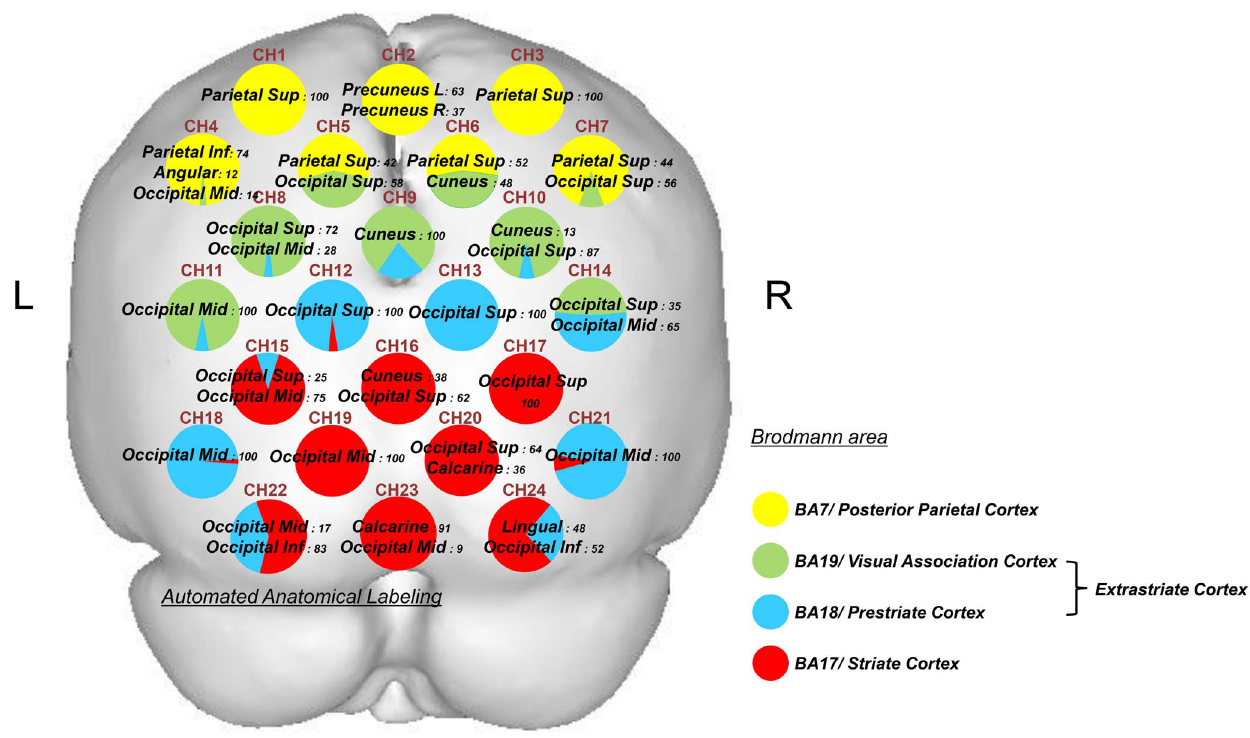
Figure 2. Anatomical identification of near-infrared spectroscopy channels. Coordinates for all probe and anatomical landmark positions (Nz, Iz, A1, A2, and Cz) were obtained using a 3-dimensional digitizer. Probabilistic registration was used to transcribe the measuring points of each subject according to the protocol of the Montreal Neurological Institute, and these points were projected onto the cortical surface. Anatomical localization was identified using the Platform for Optical Topography Analysis Tools, with reference to the Automated Anatomical Labeling system. Yellow indicates the posterior parietal cortex (BA7), green BA19 of the extrastriate cortex, blue BA18 of the extrastriate cortex, and red the striate cortex (BA17). Each circle corresponds to a channel and the pie chart within each circle shows the percentage of areas in that channel.